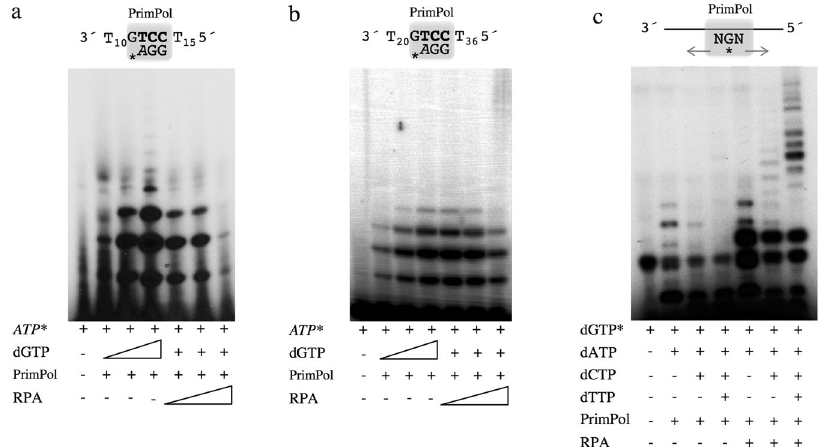
Figure 2. Modulation of PrimPol primase activity by RPA. The inhibitory effect of RPA on PrimPol primase activity was evaluated using two preferred templates differing in their size: ( a ) 29-mer GTCC or ( b ) 60-mer GTCC. The primase reaction contained 16 nM [ γ - 32 P]ATP, dGTP (1, 10, 100 µ M), 5 mM MgCl 2 and 1 mM MnCl 2 as metal cofactors, 1 µ M of the indicated template, PrimPol (200 nM), and RPA (12, 50, 200 nM) when indicated. ( c ) RPA stimulates PrimPol primase activity on a heterogeneous 65-mer oligonucleotide. The reaction contained t16 nM [ α - 32 P]dGTP, 100 µ M of dATP, dCTP and dTTP as indicated, 5 mM MgCl 2 and 1 mM MnCl 2 as metal cofactors, PrimPol (200 nM), and RPA (200 nM) when indicated. The schemes depict the template oligonucleotide, PrimPol (grey square), and the synthesized primer